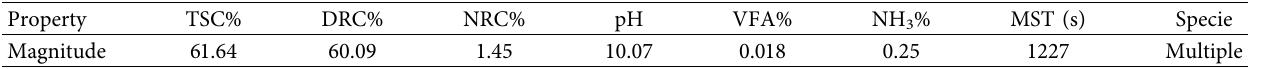
Table 2: Chemical analysis of natural rubber latex.